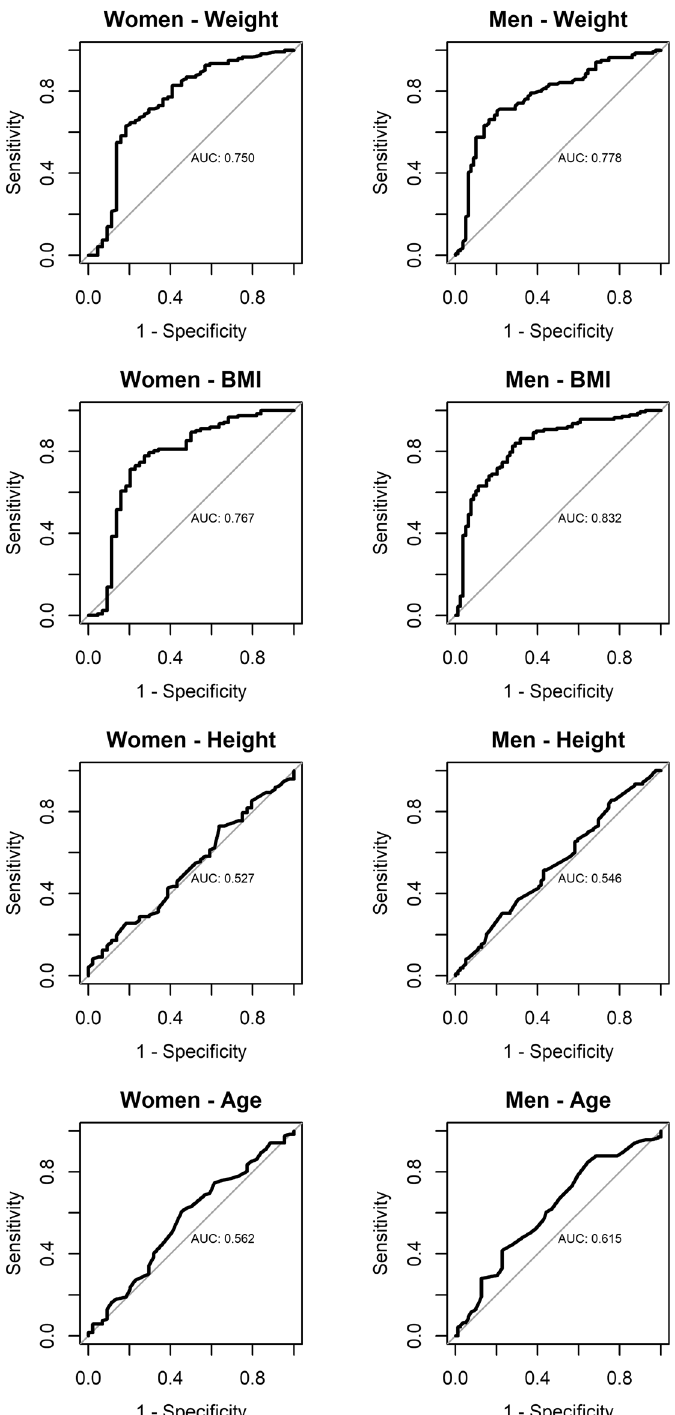
Figure 3. Receiver operator curves evaluating weight, BMI, height and age to predict intramuscular injections using the CDC guidelines (1-inch needle for females less than 200 pounds; 1.5-inch needle for females greater than 200 pounds; 1-inch needle for males less than 260 pounds; 1.5-inch needle for males greater than 260